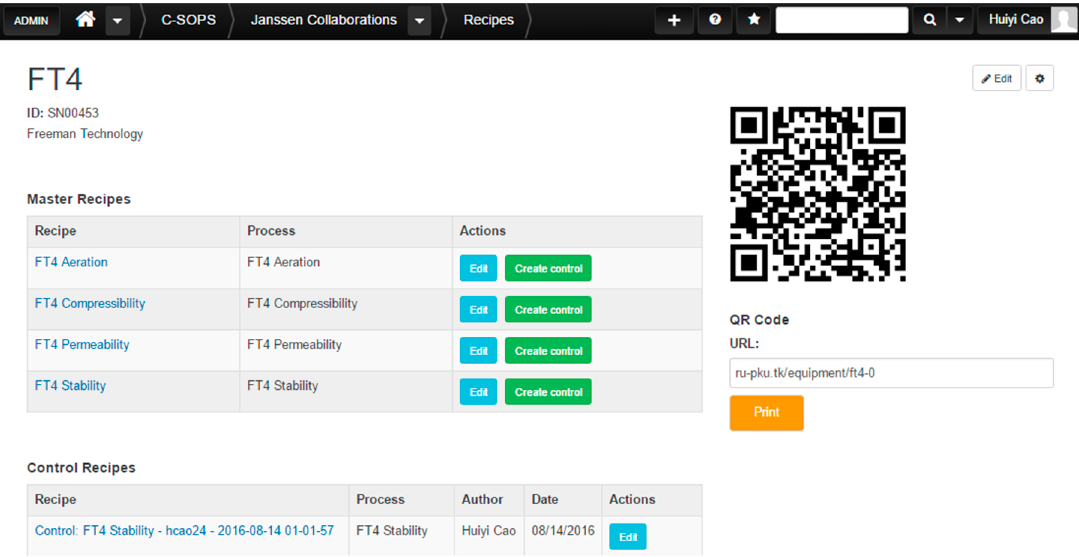
Figure 16. Equipment page of FT4 power rheometer.